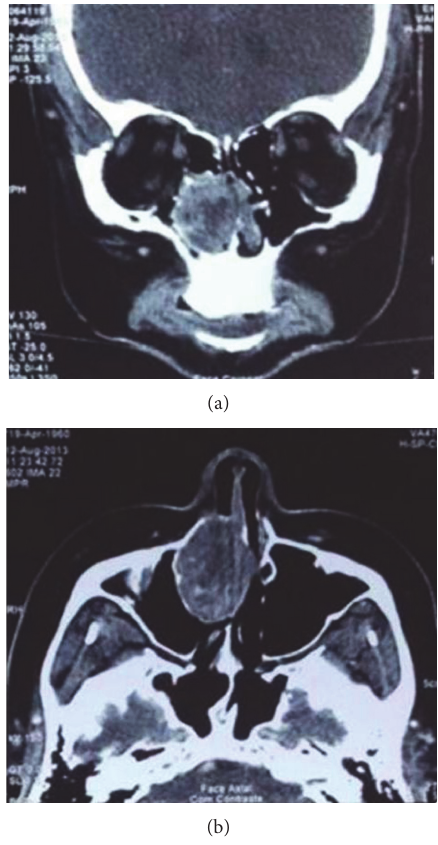
Figure 1: Computed tomography. Coronal (a) and axial (b) planes demonstrate heterogeneous contrast enhancement by the tumor.